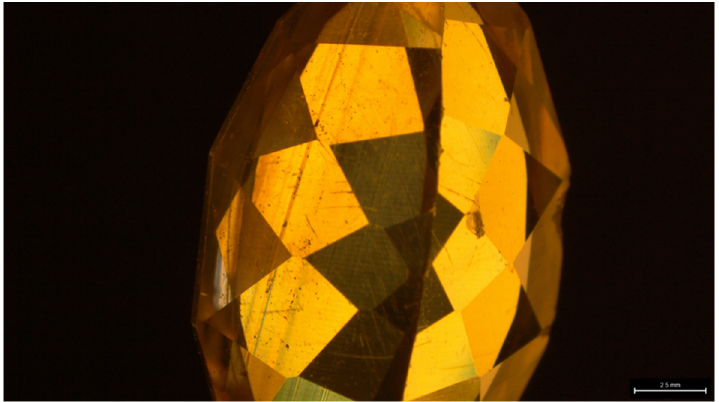
Figure 3. Parallel color bands in sample BWK2 observed from the pavilion (observed by MoticGM-168 gemstone microscopes).